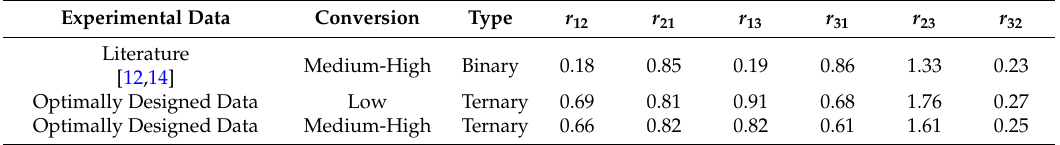
Table 4. Summary of reactivity ratio estimates for AMPS 1 /AAm 2 /AAc 3